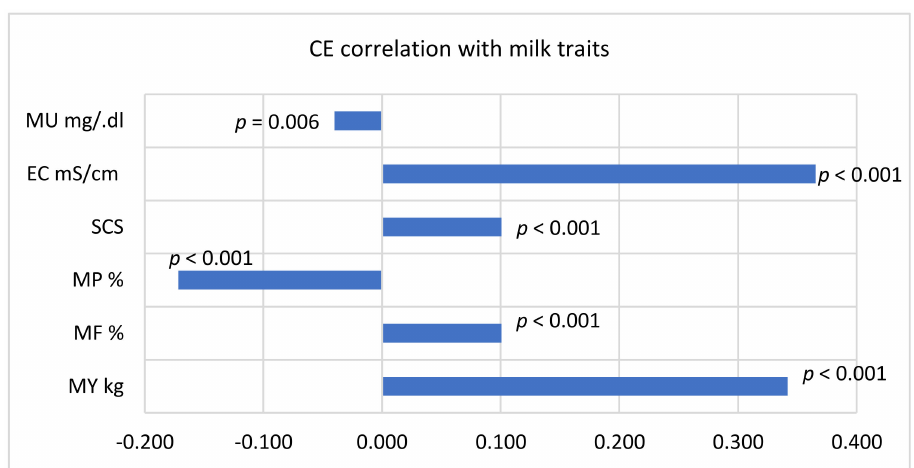
Figure 4. Calving ease score correlation with milk traits of cows. MU = milk urea; EC = milk electrical conductivity of all quarters of the udder; SCS = somatic cell score calculated as log2(number of somatic cells/100) + 3; MP = milk protein; MF = milk fat; MY = milk